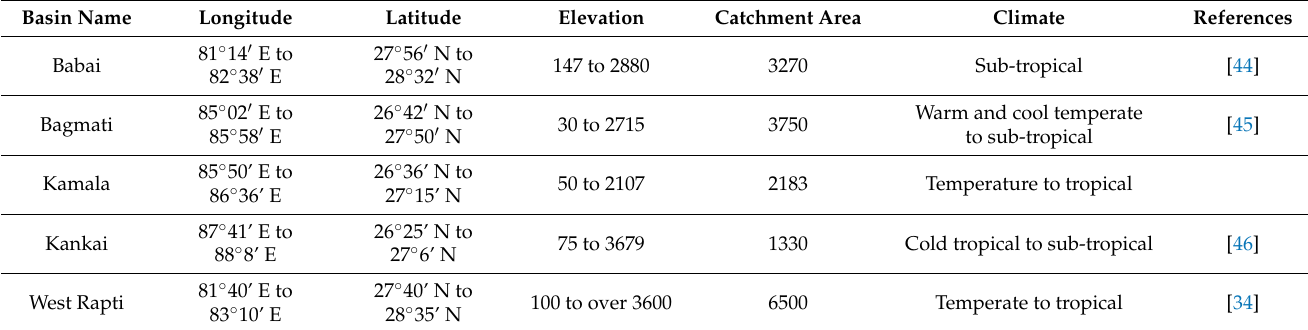
Table 1. Summary information on